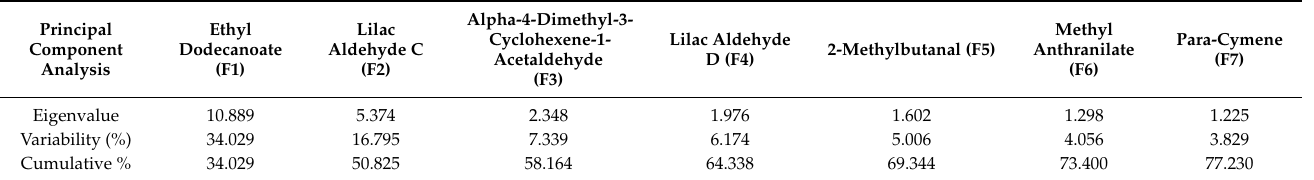
Table 2. Cumulative variability explained by the 7 volatile compounds (factor variables, PCs) with eigenvalues greater than 1 during